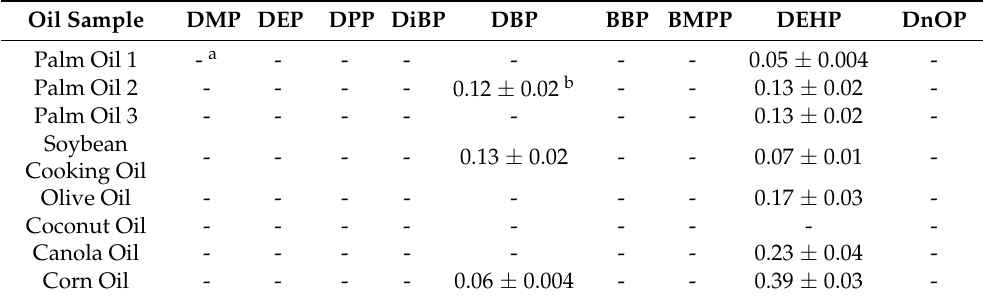
Table 4. Summary of phthalates in eight different vegetable oil ( n =